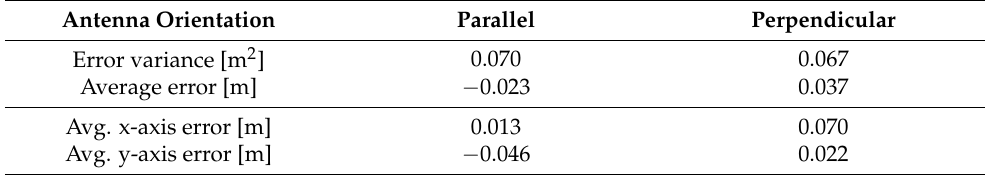
Figure 11. Best and worst cases for each tag position. Table 5. Results from the sensitivity to orientation